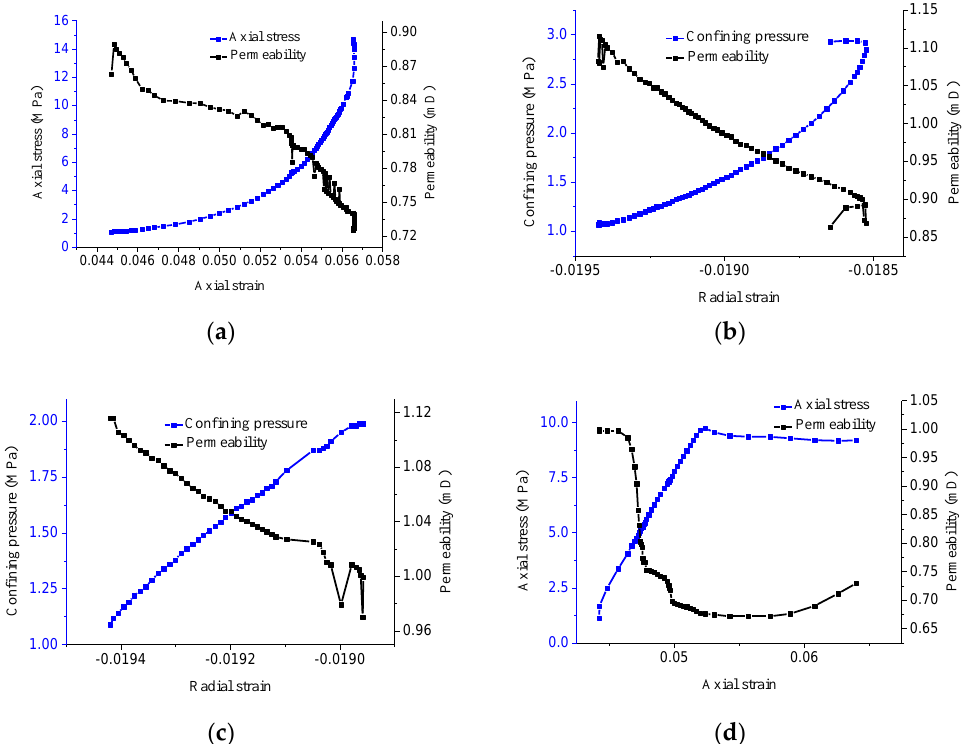
Figure 5. Experimental results of coal sample M2. ( a ) Unloading axial stress; ( b ) unloading confining pressure; ( c ) loading confining pressure; ( d ) loading to secondary damage.